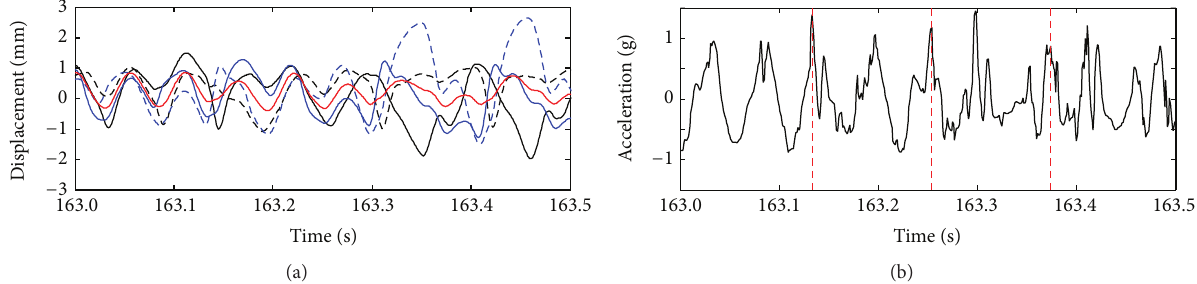
Figure 5: Simulation results of the vehicle and mecanum wheels. (a) Vertical displacements of the vehicle body (red solid line) and each wheel (blue dash: left front wheel, blue solid: right front wheel, black dash: left rear wheel, and black solid: right rear wheel), (b) vertical accelerations of the vehicle body (vertical red dash line indicates the time when the changeover of rollers occurs).